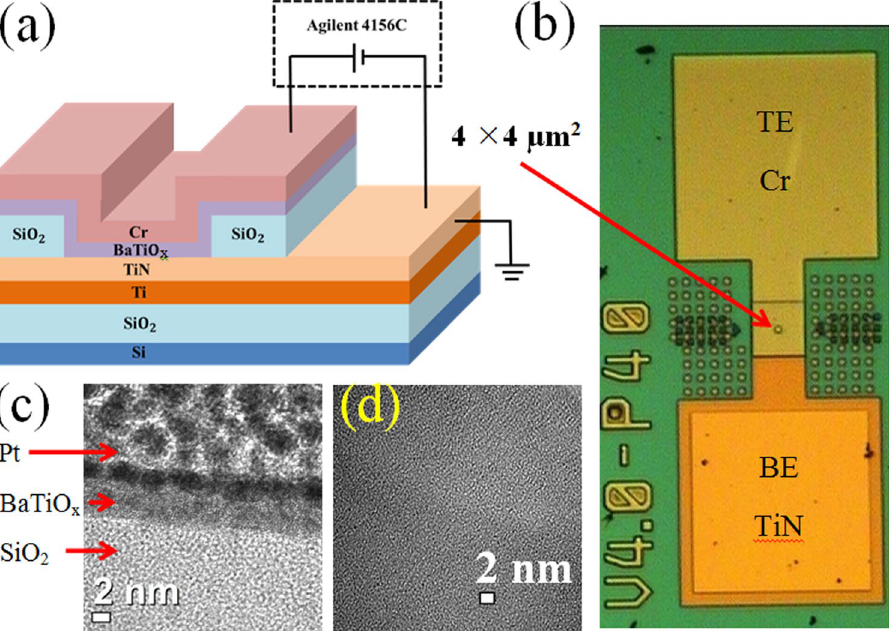
Figure 1. ( a ) Schematic view of the device and measurement setup with Agilent 4156C. ( b ) Optical microscope (OM) image of a device. ( c ) Cross-sectional HRTEM image confirms the amorphous BaTiO x layer. ( d ) Plane- view TEM image confirms amorphous BaTiO x SM